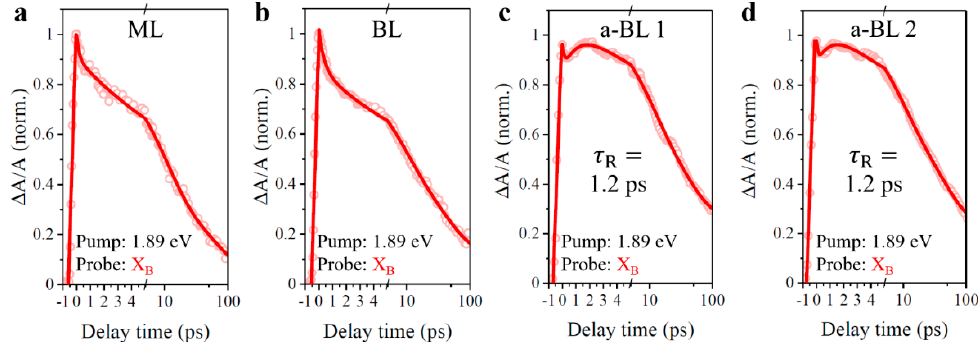
Figure 11. Pump-probe dynamics at B-exciton resonance with 1.89 eV excitation of A-exciton resonance. ( a ) ML, monolayer MoS 2 . ( b ) BL, normal bilayer. ( c ) a-BL 1, anomalous bilayer 1. ( d ) a-BL 2, anomalous bilayer 2. Samples from ( a ) to ( d ) are in accordance with region 3, region 4, region 1, and region 2 in Figure 7. X B , B-exciton resonance.